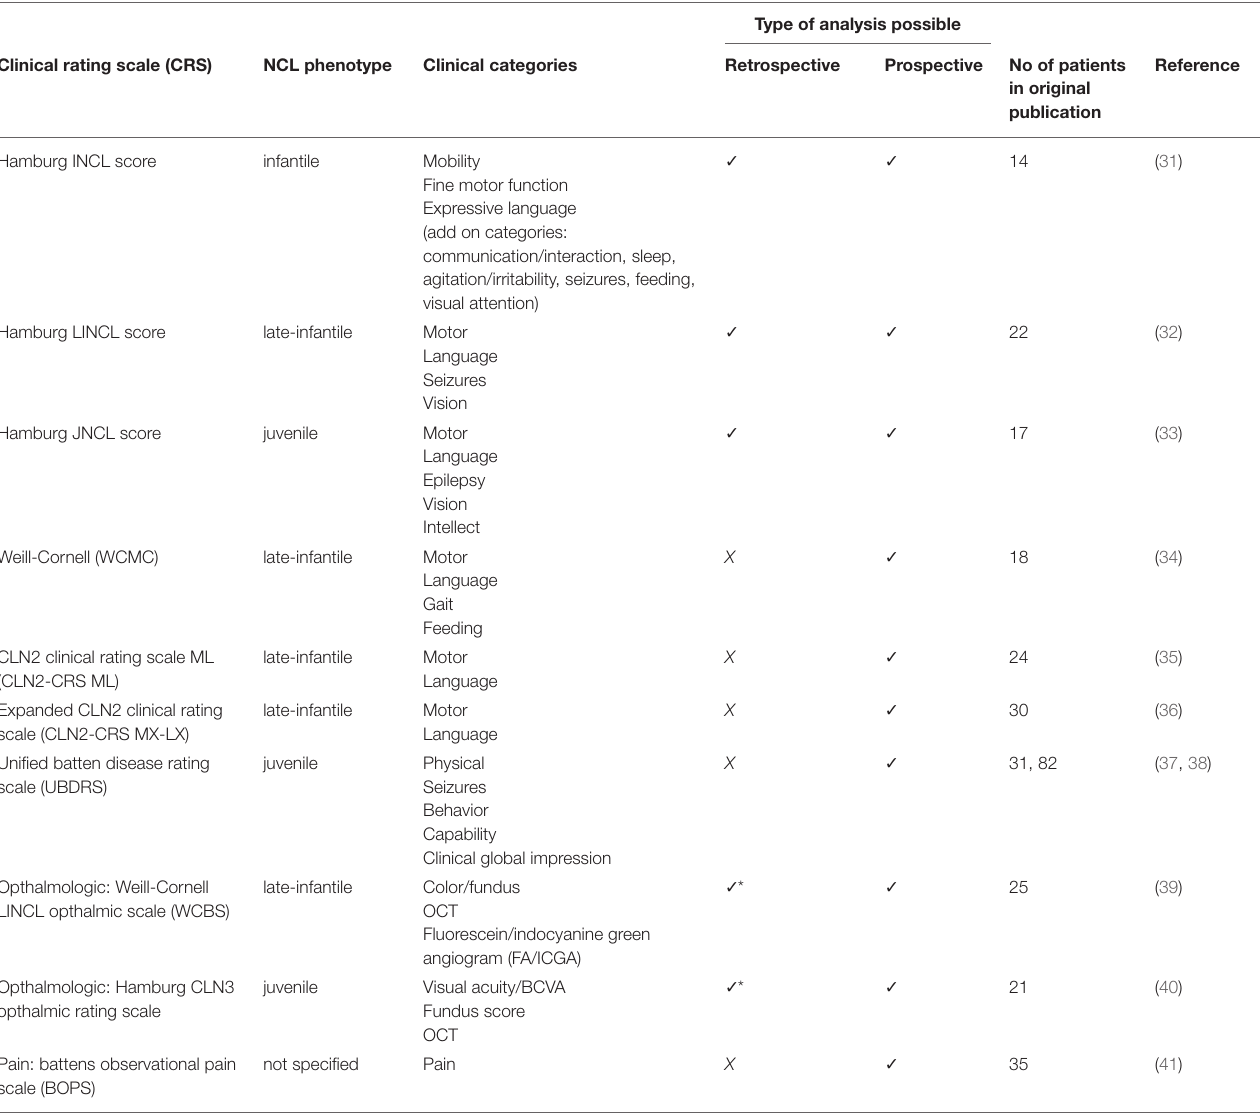
TABLE 2 | Overview of disease specific rating scales for